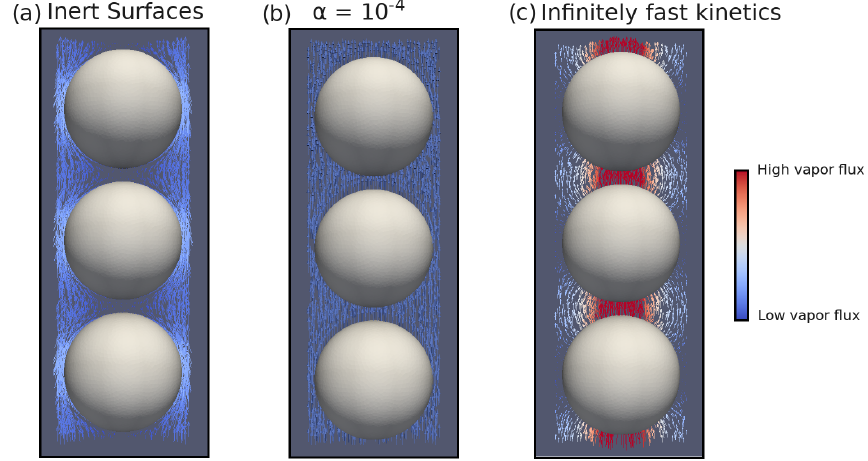
Figure 3. Disconnected ice sphere geometry with microscopic vapor fluxes in the pore space and for a 50Km − 1 thermal gradient. (a) Inert- surface case, (b) α = 10 − 4 case, and (c) infinitely fast kinetics